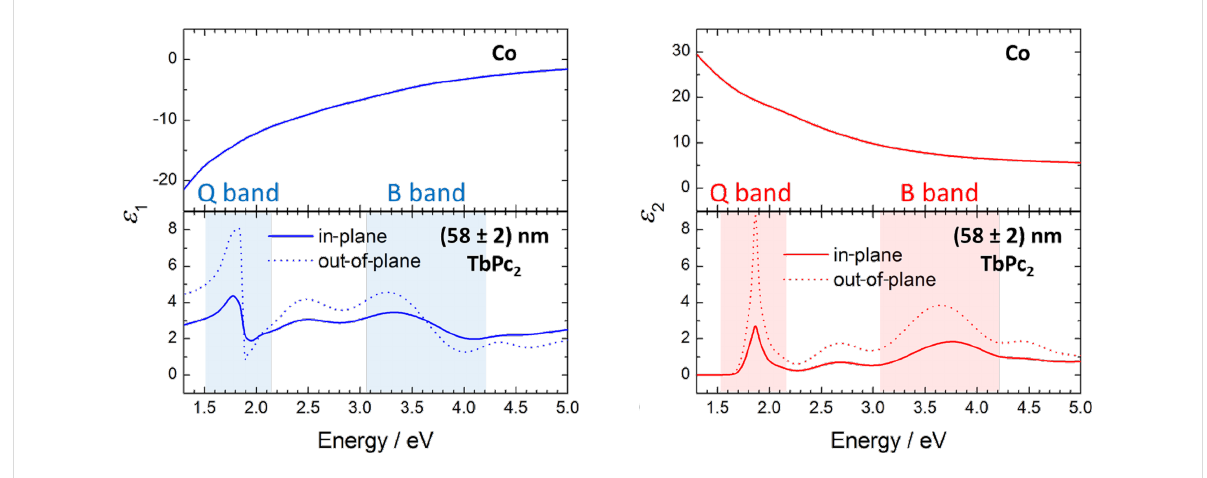
Figure 2: Dielectric function of a TbPc 2 film on cobalt. The blue lines and the red lines represent the real part (left) and the imaginary part (right), respectively, of the dielectric function. The top graphs show the dielectric function of Co and bottom graphs are obtained from 58 nm TbPc 2 on top of the Co layer.